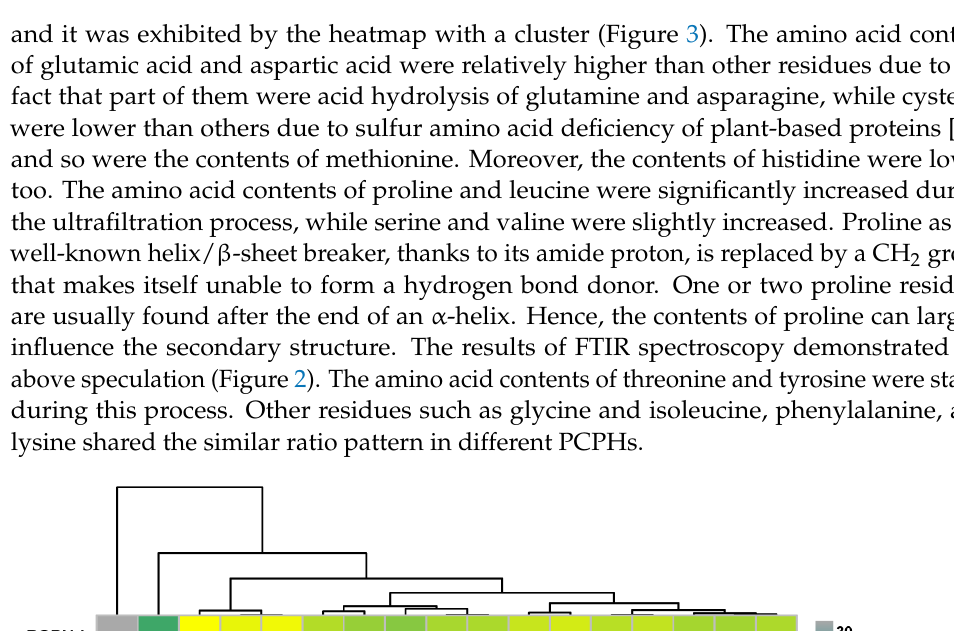
Figure 3. Heatmap with cluster by different amino acids of PCPHs based on amino acids contents (%). 2.1.3. Antioxidant Capacity of gel Chromatography Fractions from PCPH-III